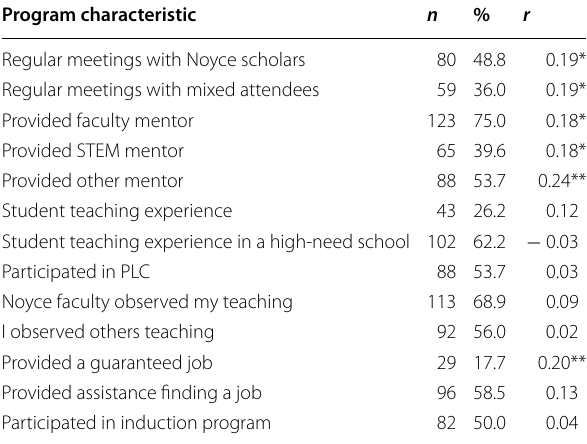
Table 4 Parameter estimates for multilevel models with ego- characteristics